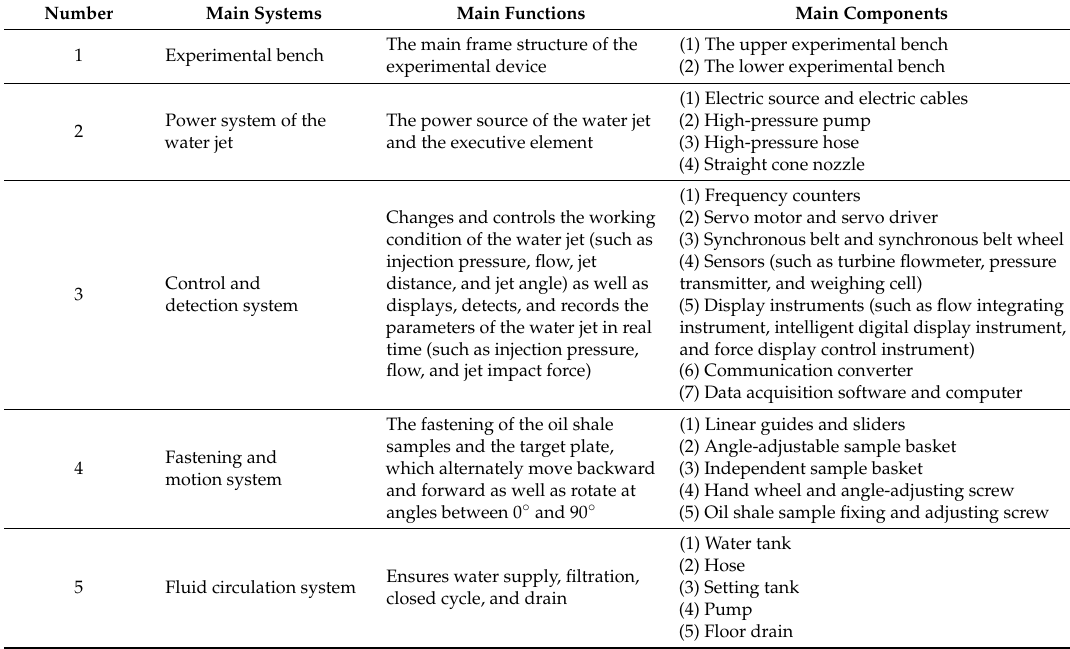
The main functions and components of the five systems of the multifunctional experimental device.